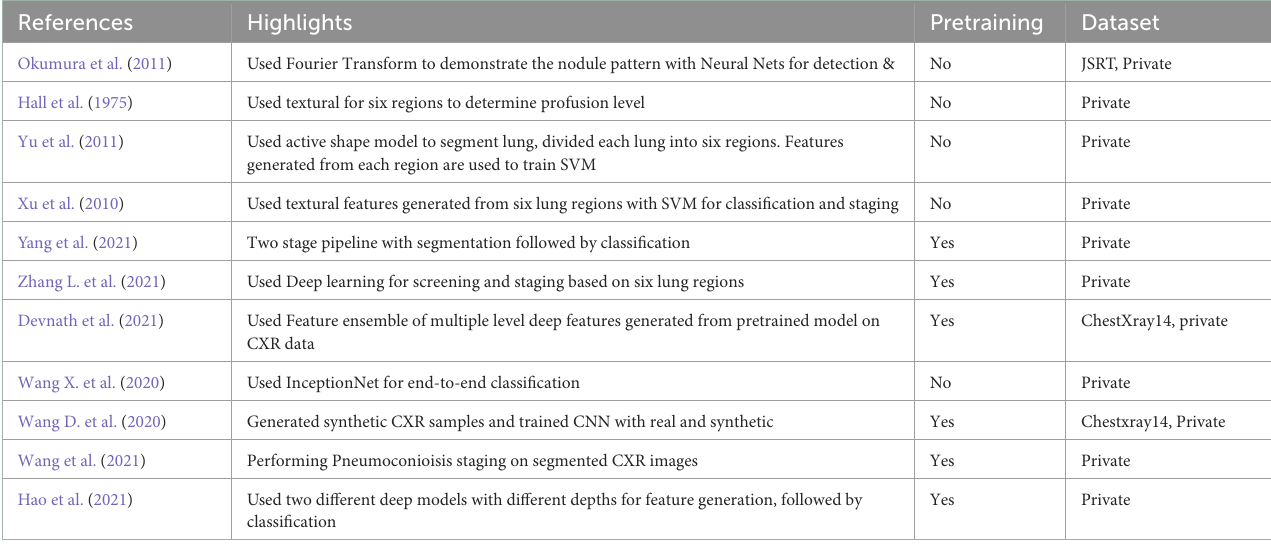
TABLE 4 Review of the literature for Pneumoconiosis detection using